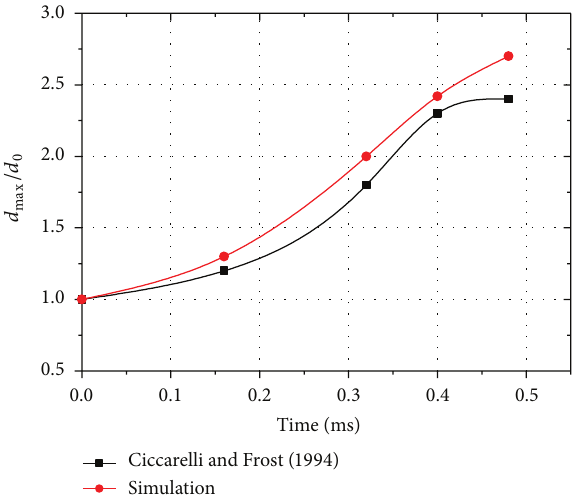
Figure 14: Comparison of numerical results with experimental data